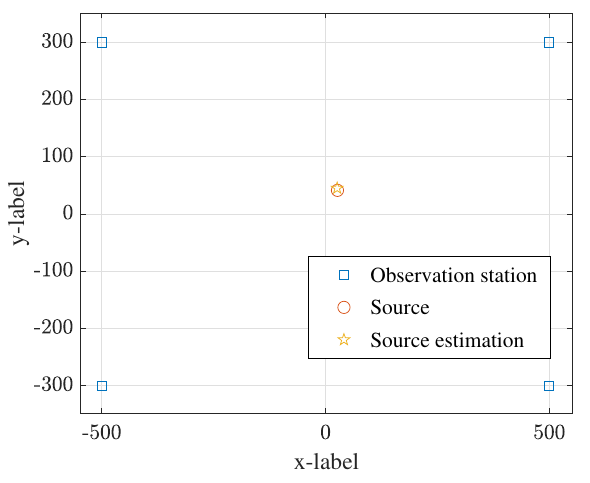
Figure 4. The positioning result of the proposed method ( M = 3 )